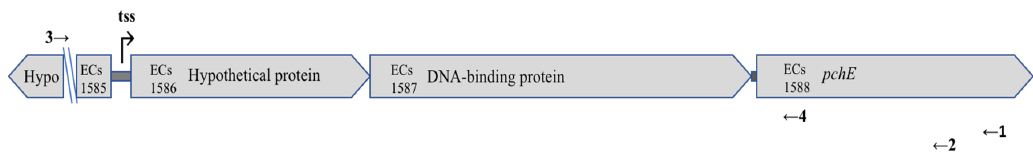
Figure 8. DNA map of O157:H7 PA20 pchE and promoter sequences showing binding sites for relevant primers used in this study. Positions and designations of pchE and upstream genes are annotated using the E. coli O157:H7 Sakai reference strain (accession #NC_002695.1). Numbers 1 and